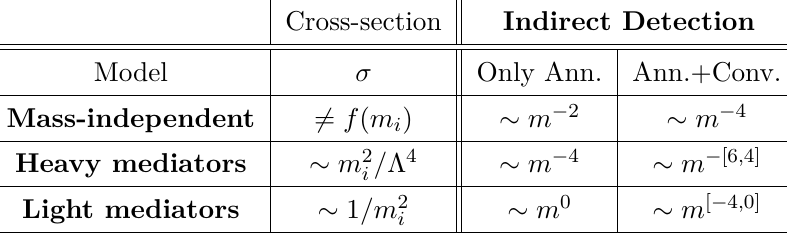
Table 3 . Indirect detection rates proportional to n 2 h σ v i for heavier components in a multi- component DM with symmetric components, for different scenarios. The exponents (left/right) indicate the extreme limits that are obtained depending on the strength of conversions